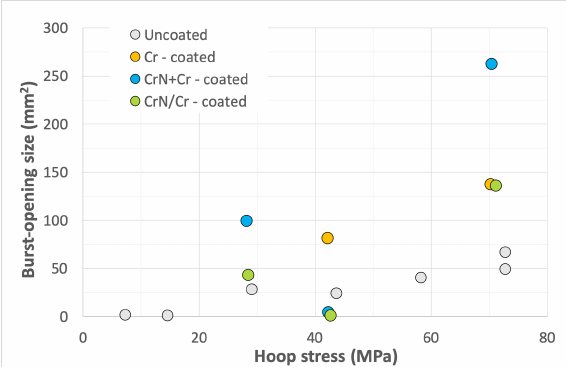
Figure 11. Creep rate at temperature 800 ◦ C in relation to hoop stress for different types of coatings and uncoated